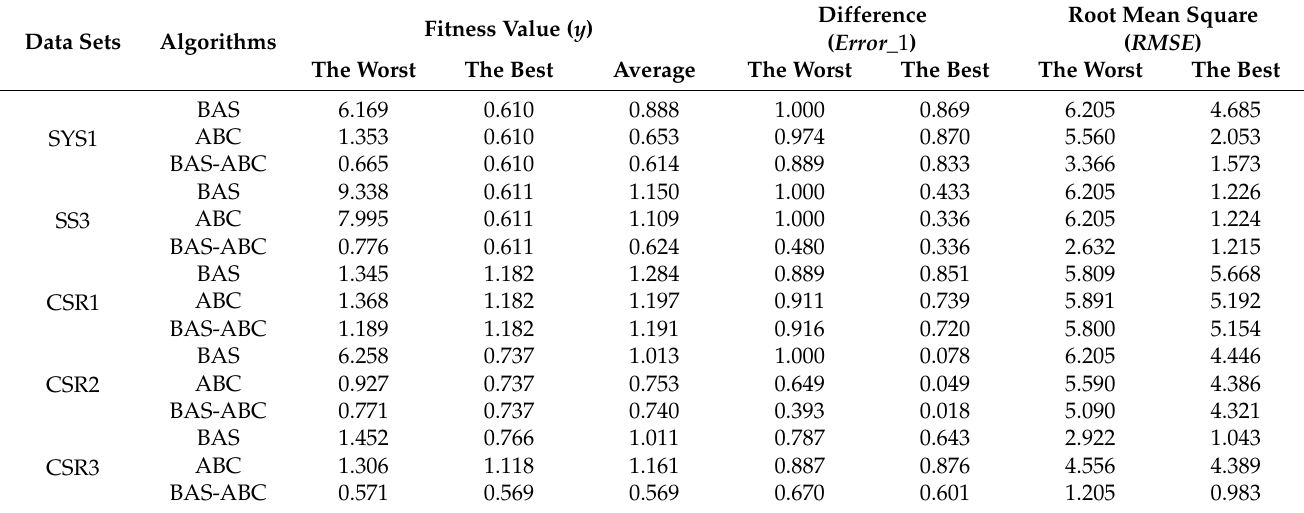
Table 1. Table 1. The best and worst values of different algorithms.